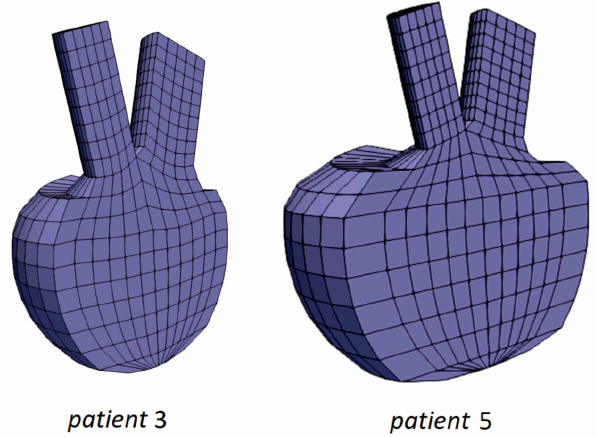
Figure 8. Left ventricle geometries for patient 3 and patient 5.